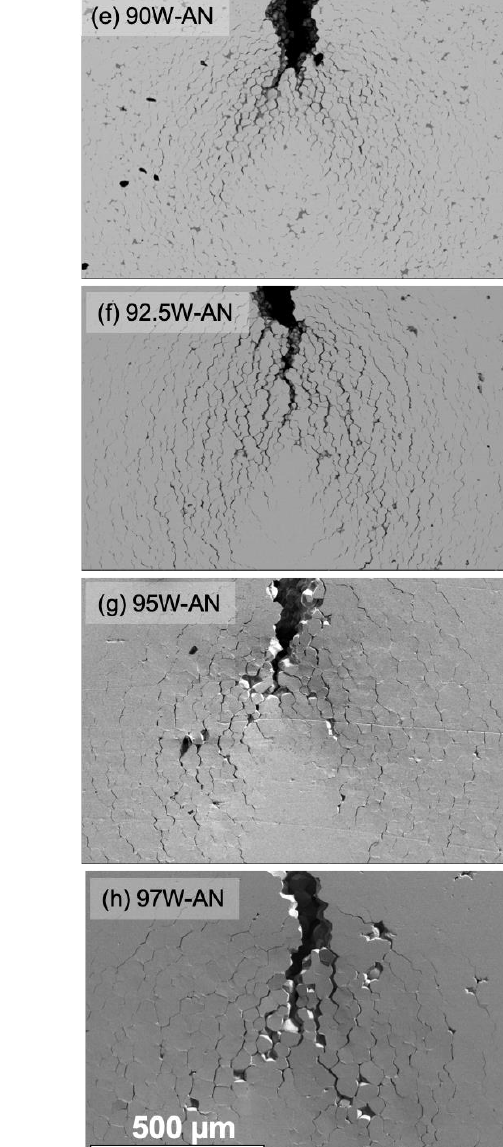
12 of 17 Figure 7. SEM micrographs probed on the fractured face for tensile specimens for ( a – d ) AS and ( e – h ) AN 90, 92.5, 95, and 97W WHAs, respectively. 4.2. Fracture Mechanisms in Bend Tests Annealing also leads to a major change in the microcracking pattern associated with macrocrack propagation, as illustrated in Figure 8. In contrast to more localized near-tip microcracking in the AS condition, annealing leads to much more and widely distributed